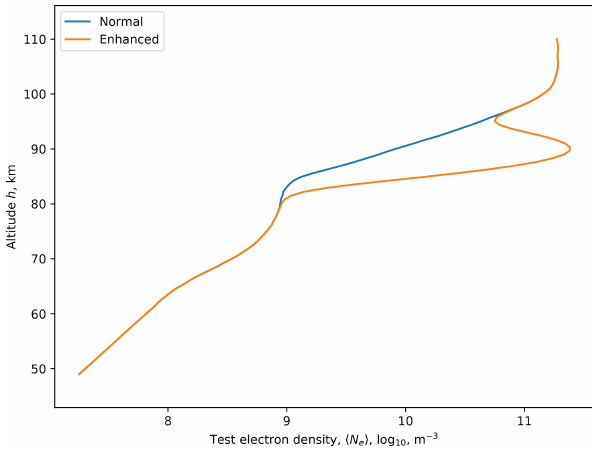
Figure 3. Electron density profiles for normal and enhanced condi- tions.